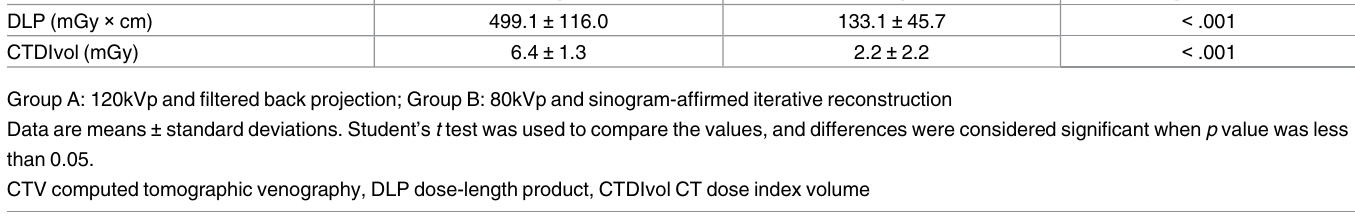
Table 4. Comparison of radiation dose of two different CTV protocols.